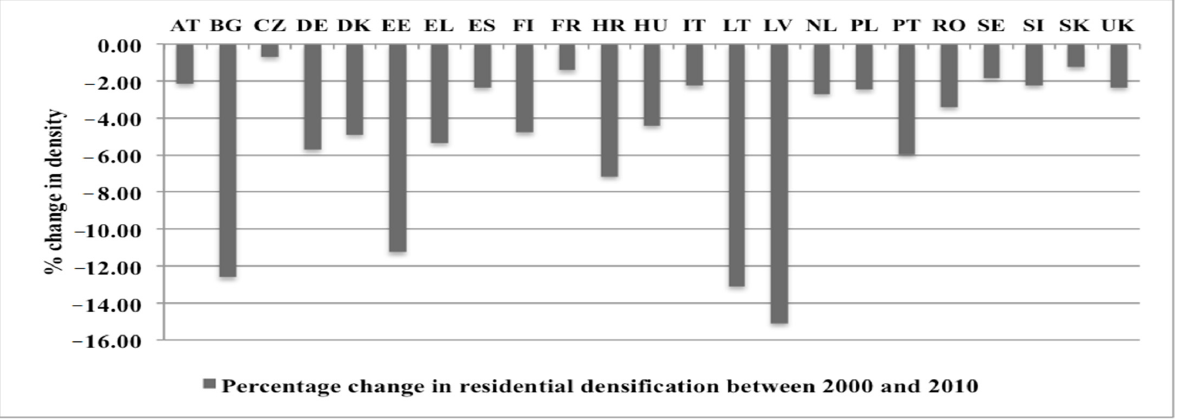
Figure 6. Percentage change in residential densities between 2000 and 2010 in the declining regions in Europe. Note: Belgium, Cyprus, Ireland, Luxembourg, and Malta are not included in the figure, considering that there are no declining regions in these countries. Results of regressions explaining change in residential densities are provided in Table 4. As has been found by Broitman and Koomen [48], R-squared values yielded that the variance in residential density change was more difficult to explain than variance in residential expansion; for unclear reasons, residential density changes are the result of a much more evasive process. Some results are reasonably monotone despite the set of observations on which the explanatory models are fitted. Higher slopes and higher conditions. Ceteris paribus, North European countries and metropolis regions always